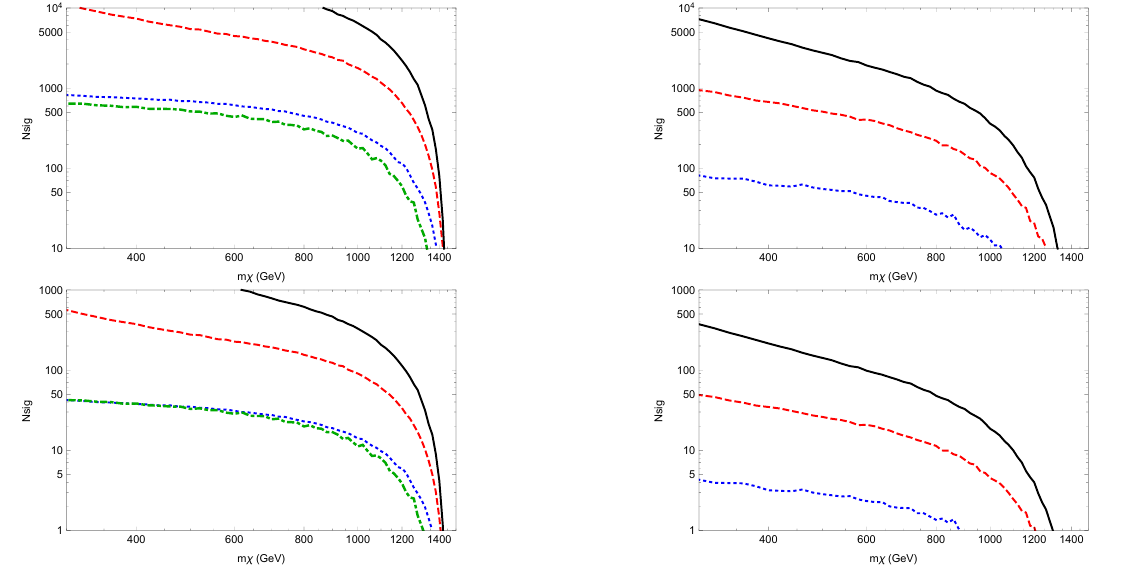
Figure 6 . Number of single-disappearing-track events expected in our models as a function of mass. The left (right) side shows fermion (scalar) models. The upper row assumes 100% e(cid:14)ciency for photon and disappearing track reconstruction; the lower row assumes the energy-dependent photon e(cid:14)ciency and 10% for disappearing tracks. The di(cid:11)erent lines label models with the same convention as (cid:12)gure